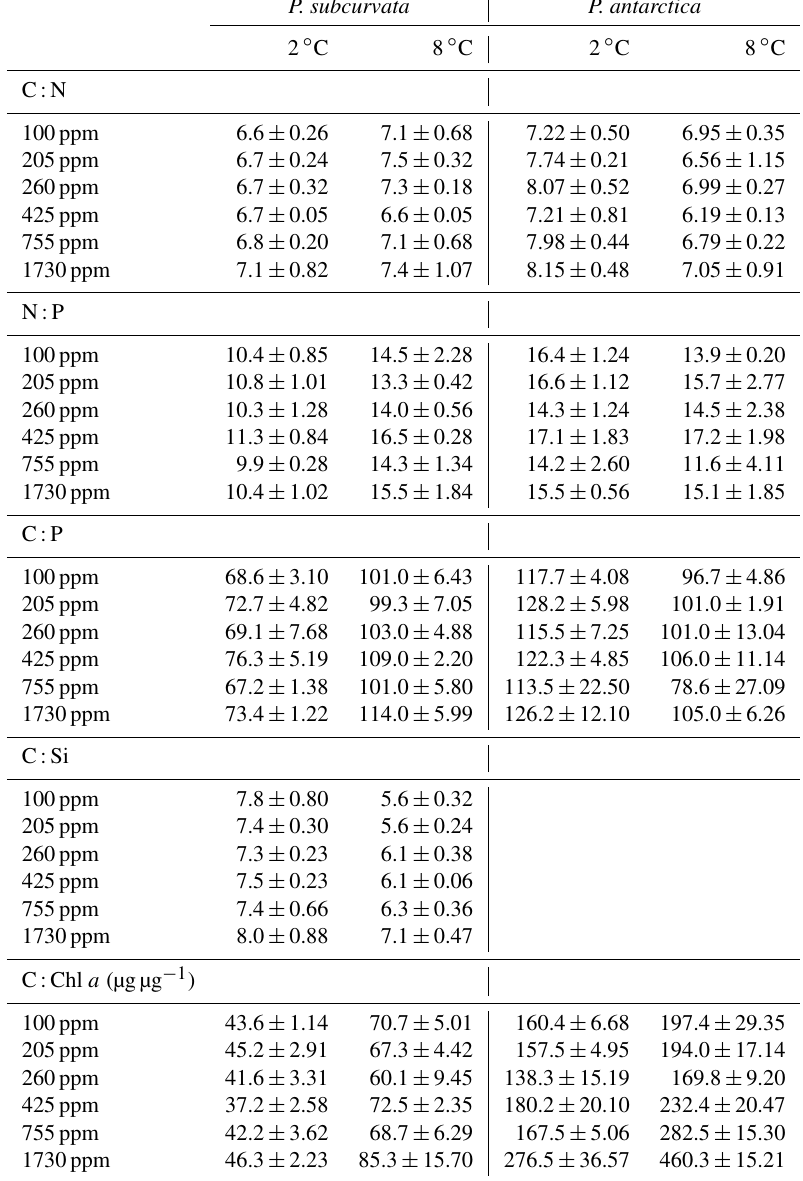
Table 5. The effects of CO 2 on the C:N, N:P, C:P, C:Si, and C:Chl a ratios of P. subcurvata and P. antarctica at 2 and 8 ◦ C. Values represent the means and errors are the standard deviations of triplicate